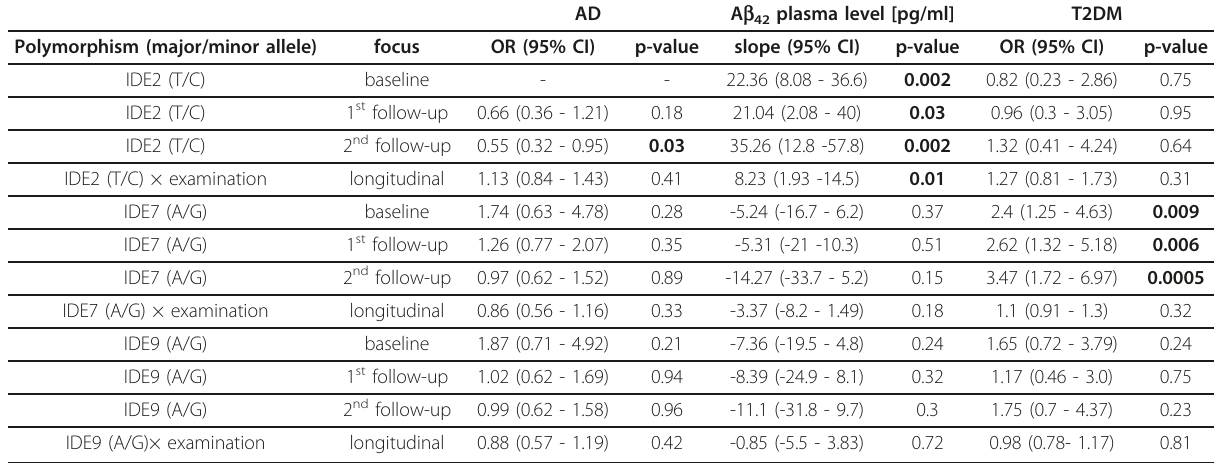
Table 1 Association results of insulin degrading enzyme